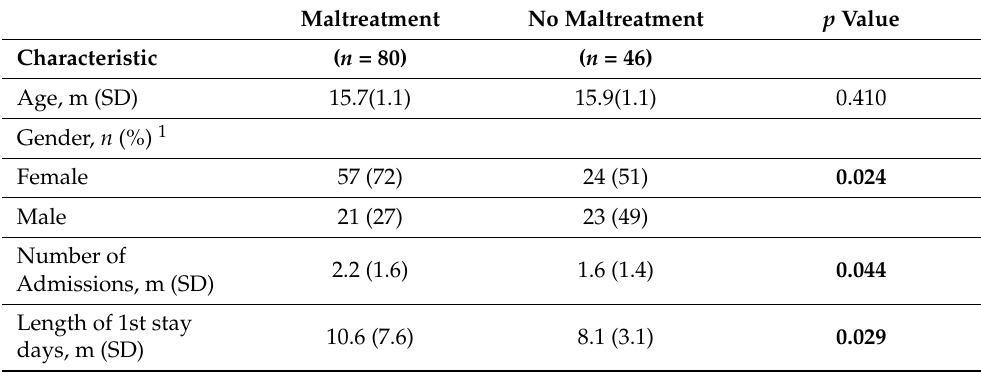
Table 1. Characteristics of Patients.